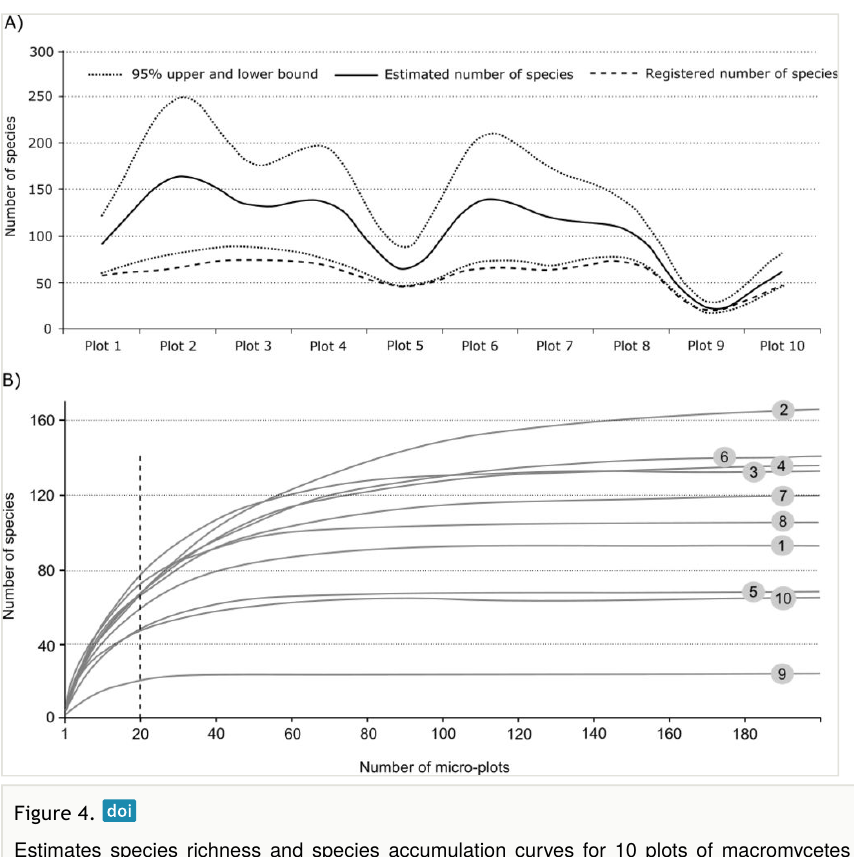
Estimates species richness and species accumulation curves for 10 plots of macromycetes observations in di ff erent forest types in vicinities of Khanty-Mansiysk, West Siberia: